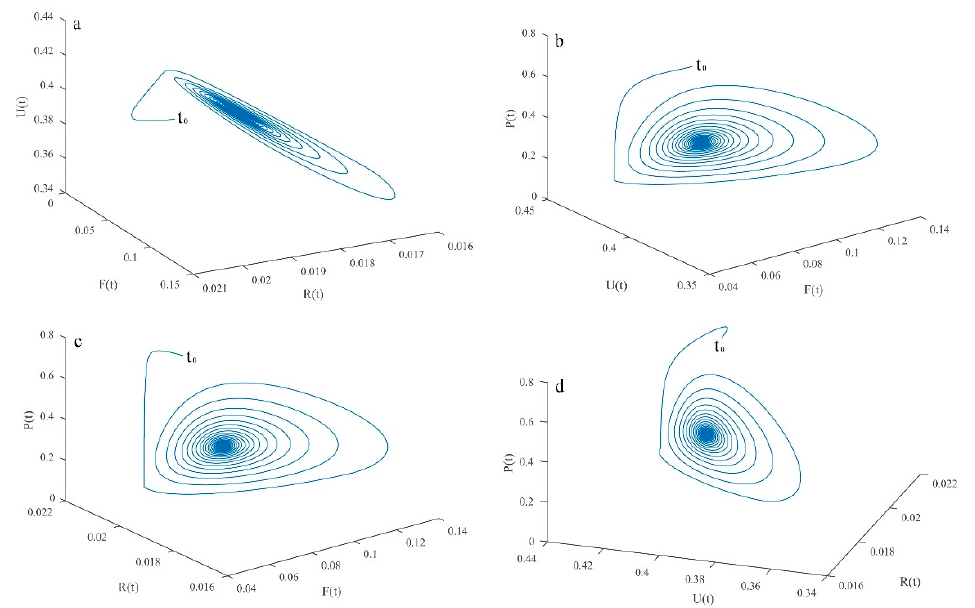
Figure 4. Three-dimensional map of human–land evolution in Yuxi City when τ = 700 (( a ) three- dimensional evolution of the unused land, forest and grass land and production and living land over time; ( b ) three-dimensional evolution of the population, unused land, and forest and grass land over time; ( c ) three-dimensional evolution of the population, production and living land and forest and grass land over time; ( d ) three-dimensional evolution of the population, unused land and production and living land over time).